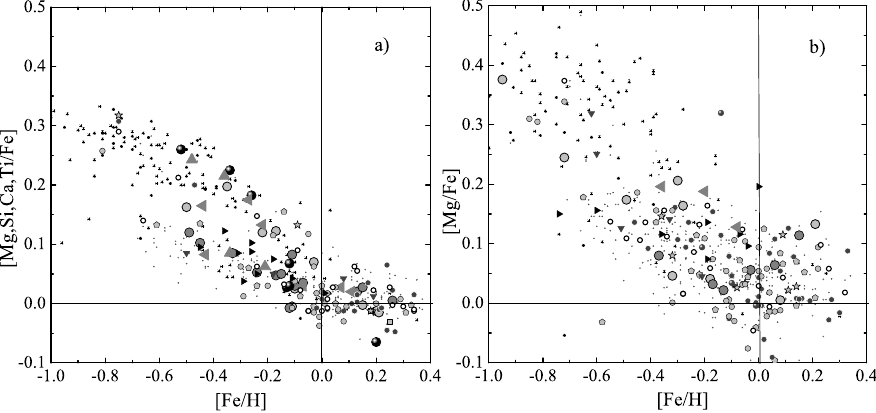
Fig. 2. Dependence of the relative abundances of four α -elements (Bensby et al. 2014) and magnesium (Borkova & Marsakov 2005) on metallicity. The symbols are the same as in Fig.